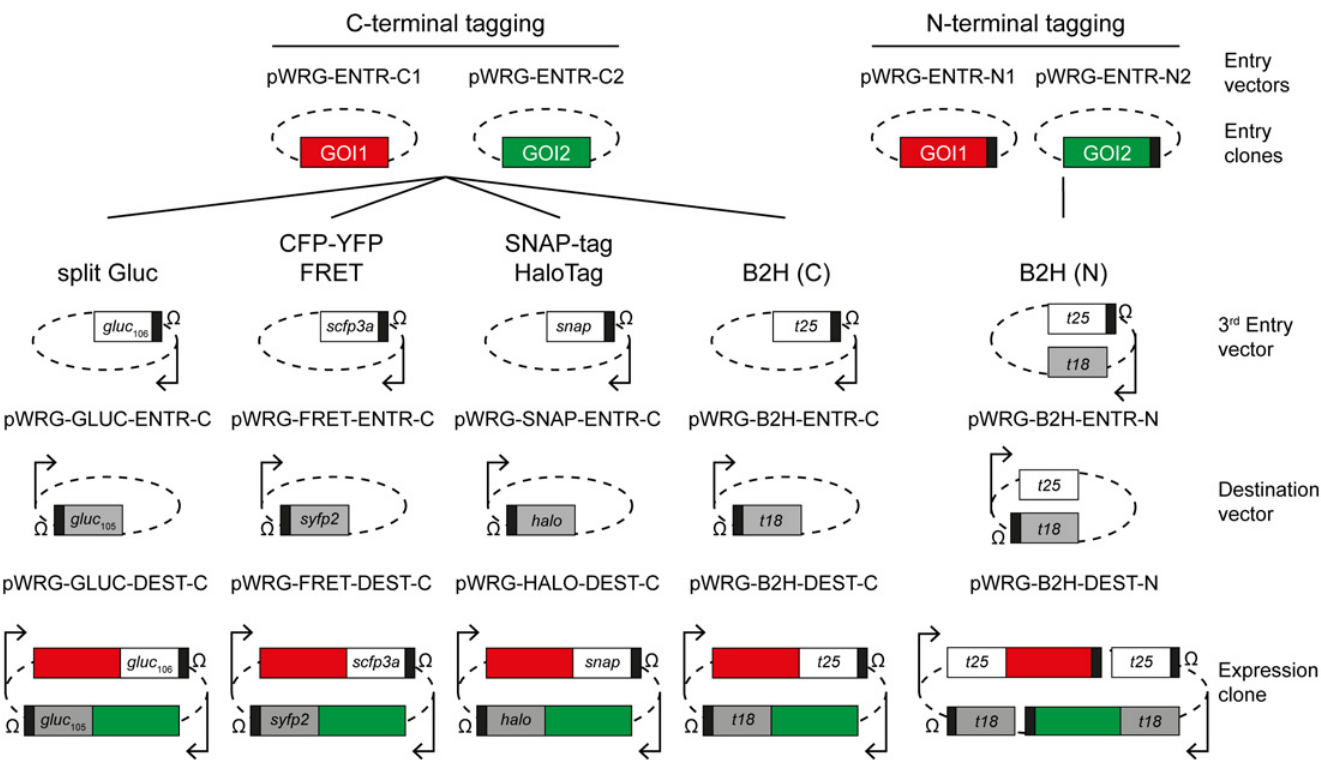
Fig 3. Overview of the system and plasmid combinations. Two Entry vectors suitable for C-terminal (left) or N-terminal (right) tagging are modified with genes of interest (GOI1 = red, GOI2 = green). The two resulting Entry clones are combined in a MultiSite Gateway LR reaction with an application-specific 3 rd Entry clone and Destination vector (below) resulting in the desired Expression clone (bottom). Plasmids pWRG-B2H-ENTR-N and pWRG-B2H-DEST-N allow for N-terminal tagging in bacterial two hybrid (B2H) applications if used together with compatible pWRG-ENTR-N1/2-derived Entry clones (right). Boxes represent the genes or gene fragments as indicated ( gluc 105 = Gluc M18 – 105 , gluc 106 = Gluc 106 – 185 , scfp3a = Super CFP 3a, syfp2 = Super YFP 2, snap = SNAP-tag, halo = HaloTag 7, t18 = T18 fragment of CyaA from B . pertussis , t25 = T25 fragment of CyaA from B . pertussis ), black rectangles symbolize stop- codons, tetracycline-inducible promoters are depicted as arrows and Ω stand for rrnB -derived terminators. Resistance cassettes, att R- and att L sites as well as by-products of the reactions are not shown.